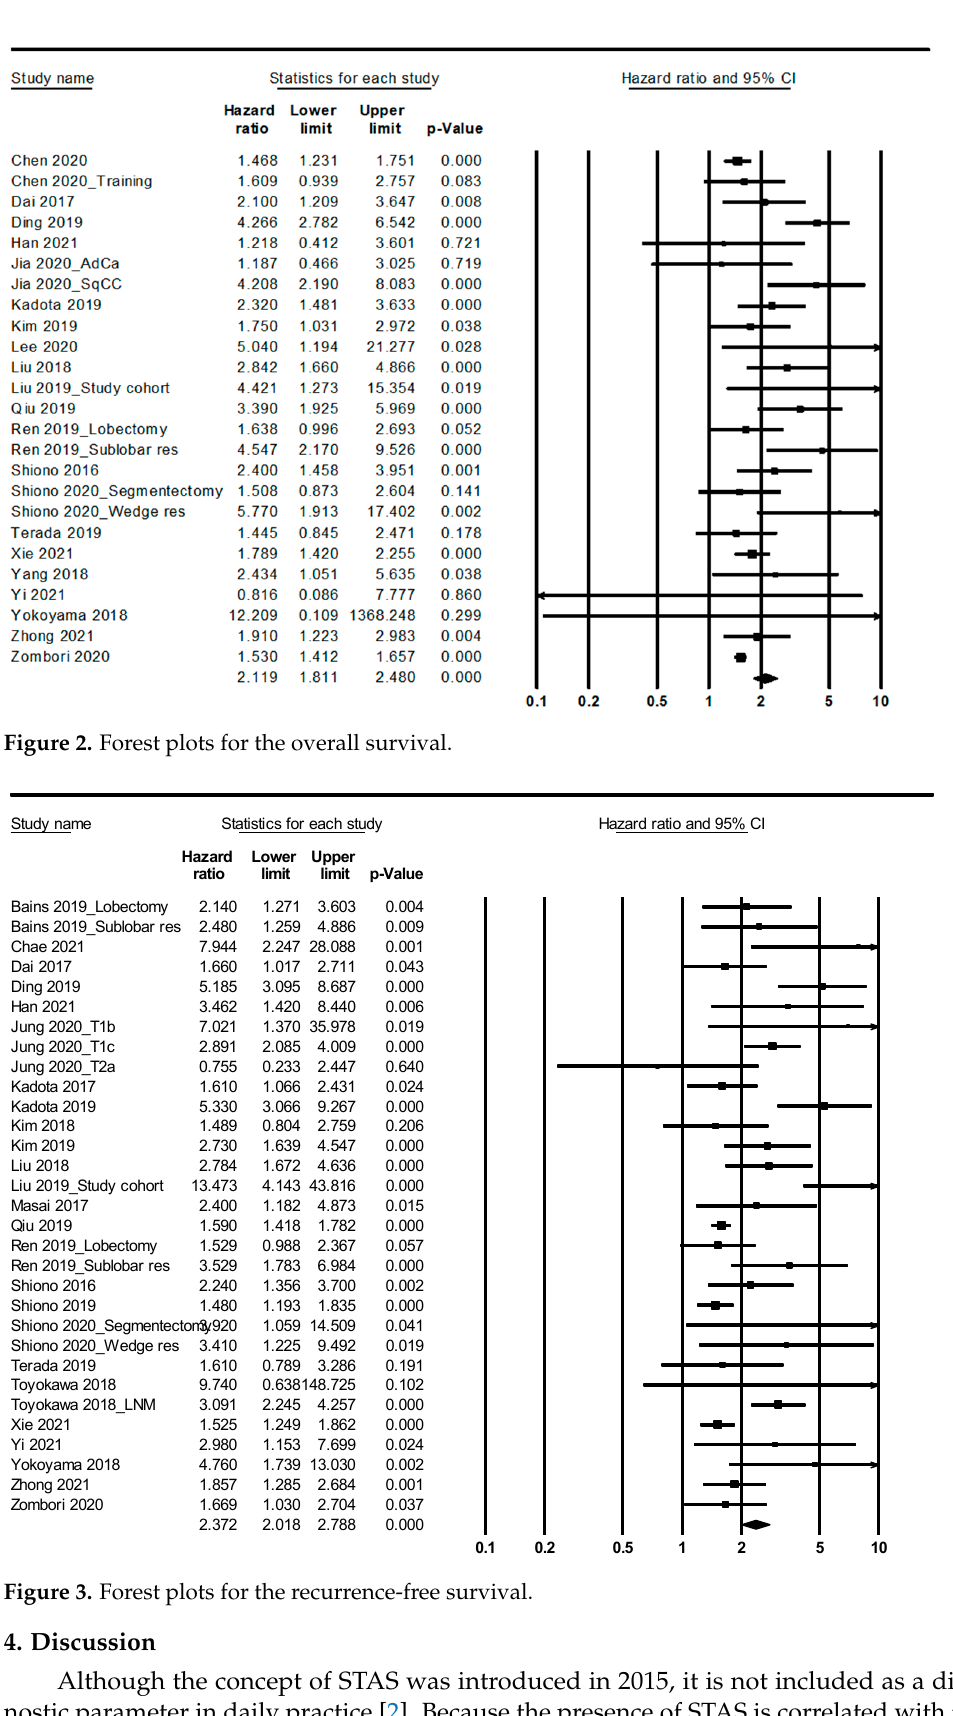
7 of 14 Table 4. Comparisons of genetic mutation between lung cancers with STAS and non-STAS. Number of Subset